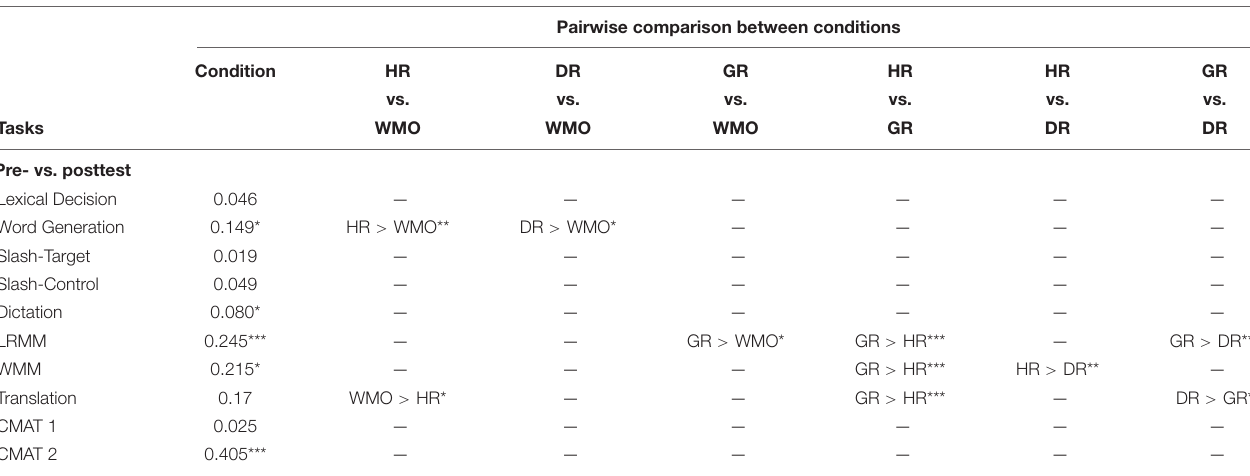
TABLE 4 | Summary table of simple effect test among conditions.